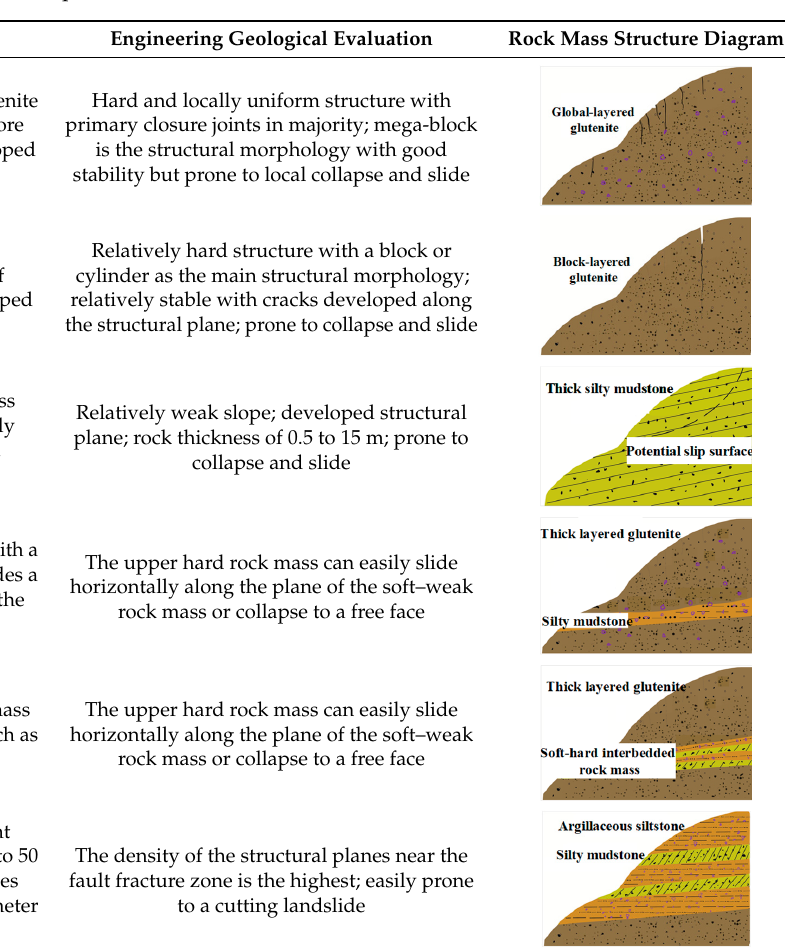
Table 1. Rock mass structure of red-bed slopes in South China.